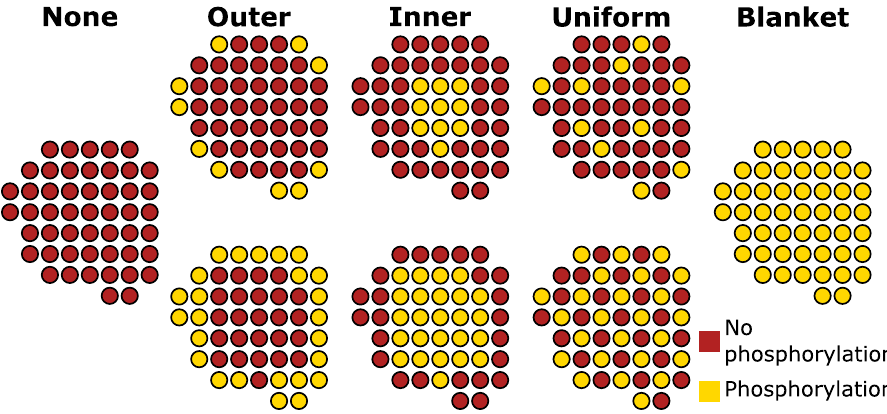
Fig 3. Schematic of the different phosphorylation setups used in the model demonstrated using the geometry G1 as an example case. For the three phosphorylation patterns (outer, inner and uniform) two configurations were assumed: 20% (upper row) and 50% (lower row) of the RyRs being